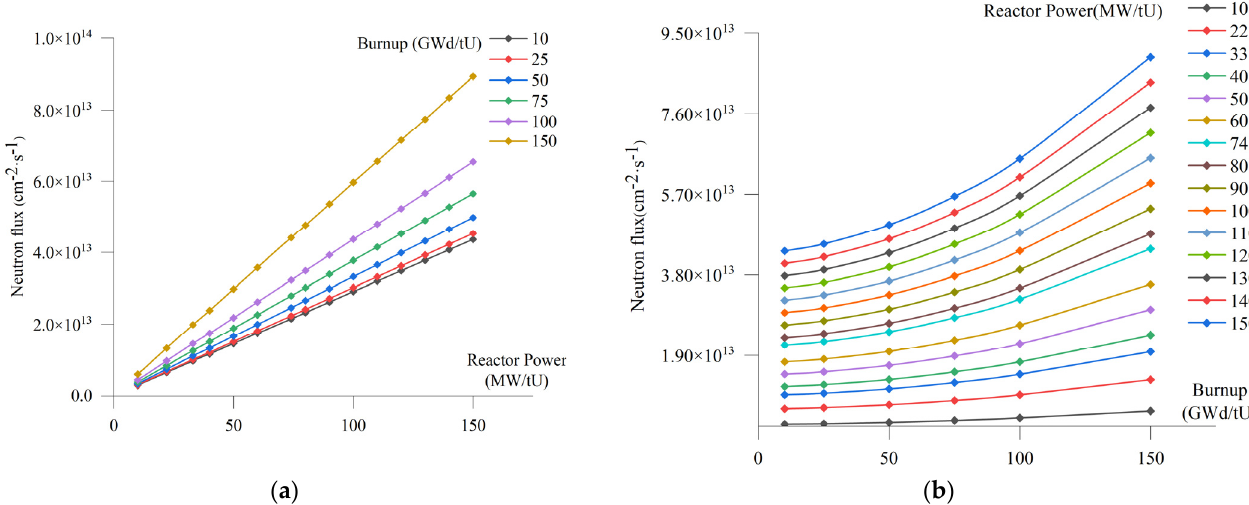
Figure 6. Relationships between the neutron flux and ( a ) reactor power and ( b ) burnup.